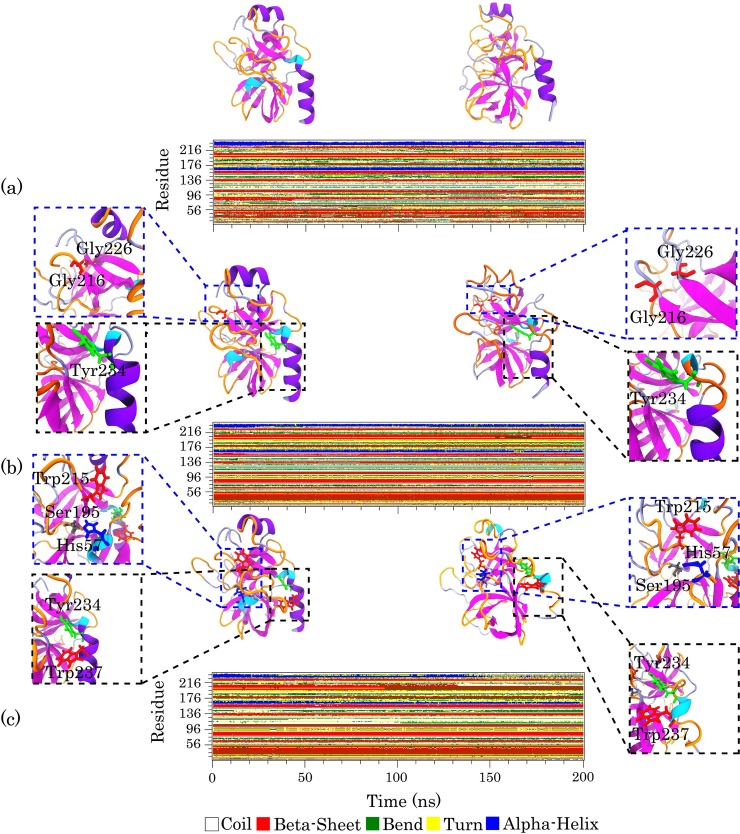
Time evolution of the secondary structure of the enzyme during MD simulations generated by DSSP for (a) the enzyme in water (as control), (b) system 1, and (c) system 2. The cartoon model of the first and the last snapshots of MD of the enzyme structure are shown in left and right respectively. Changes of secondary structure of several residues are shown, for instance. The alpha helix, 310 helix, beta sheet, turns, and coil structures are colored in violet, cyan, magenta, orange, and ice blue, respectively. For the DSSP analysis of the enzyme in system 3 and system 4, refer to the supplementary information.